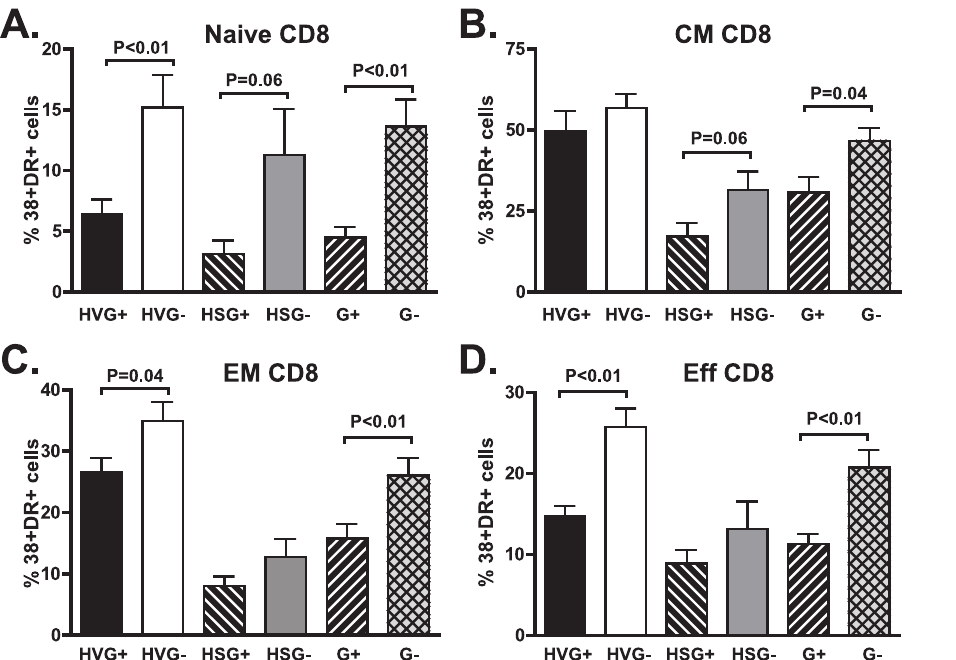
Figure 3. GBV-C is associated with reduced activation in CD8 + T cell subsets in treated and untreated HIV-infected individuals. The percentage of naive (A), central memory (CM; B), effector memory (EM; C) and effector (Eff; D) CD8 + T cells expressing CD38 and HLA-DR differed between GBV-C viremic (G + ) subjects and those without GBV-C viremia (G-). Results of subjects not receiving combination antiretroviral therapy (HIV viremic; HV) or those with suppressed HIV RNA on therapy (HS) and statistical evaluation are provided.